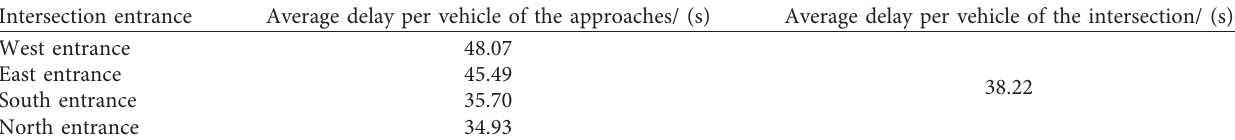
Table 5: Delay data at the intersection.